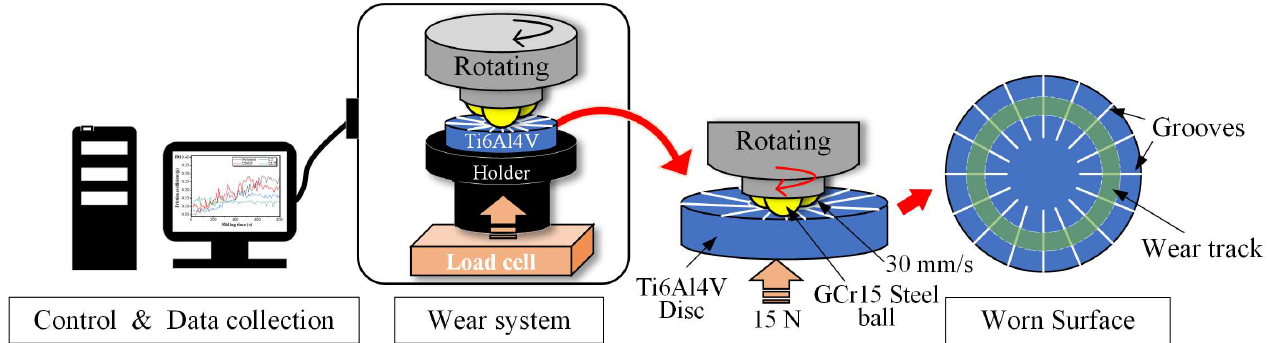
Figure 3. Schematic diagram of the ball-on-disc tribological test system.